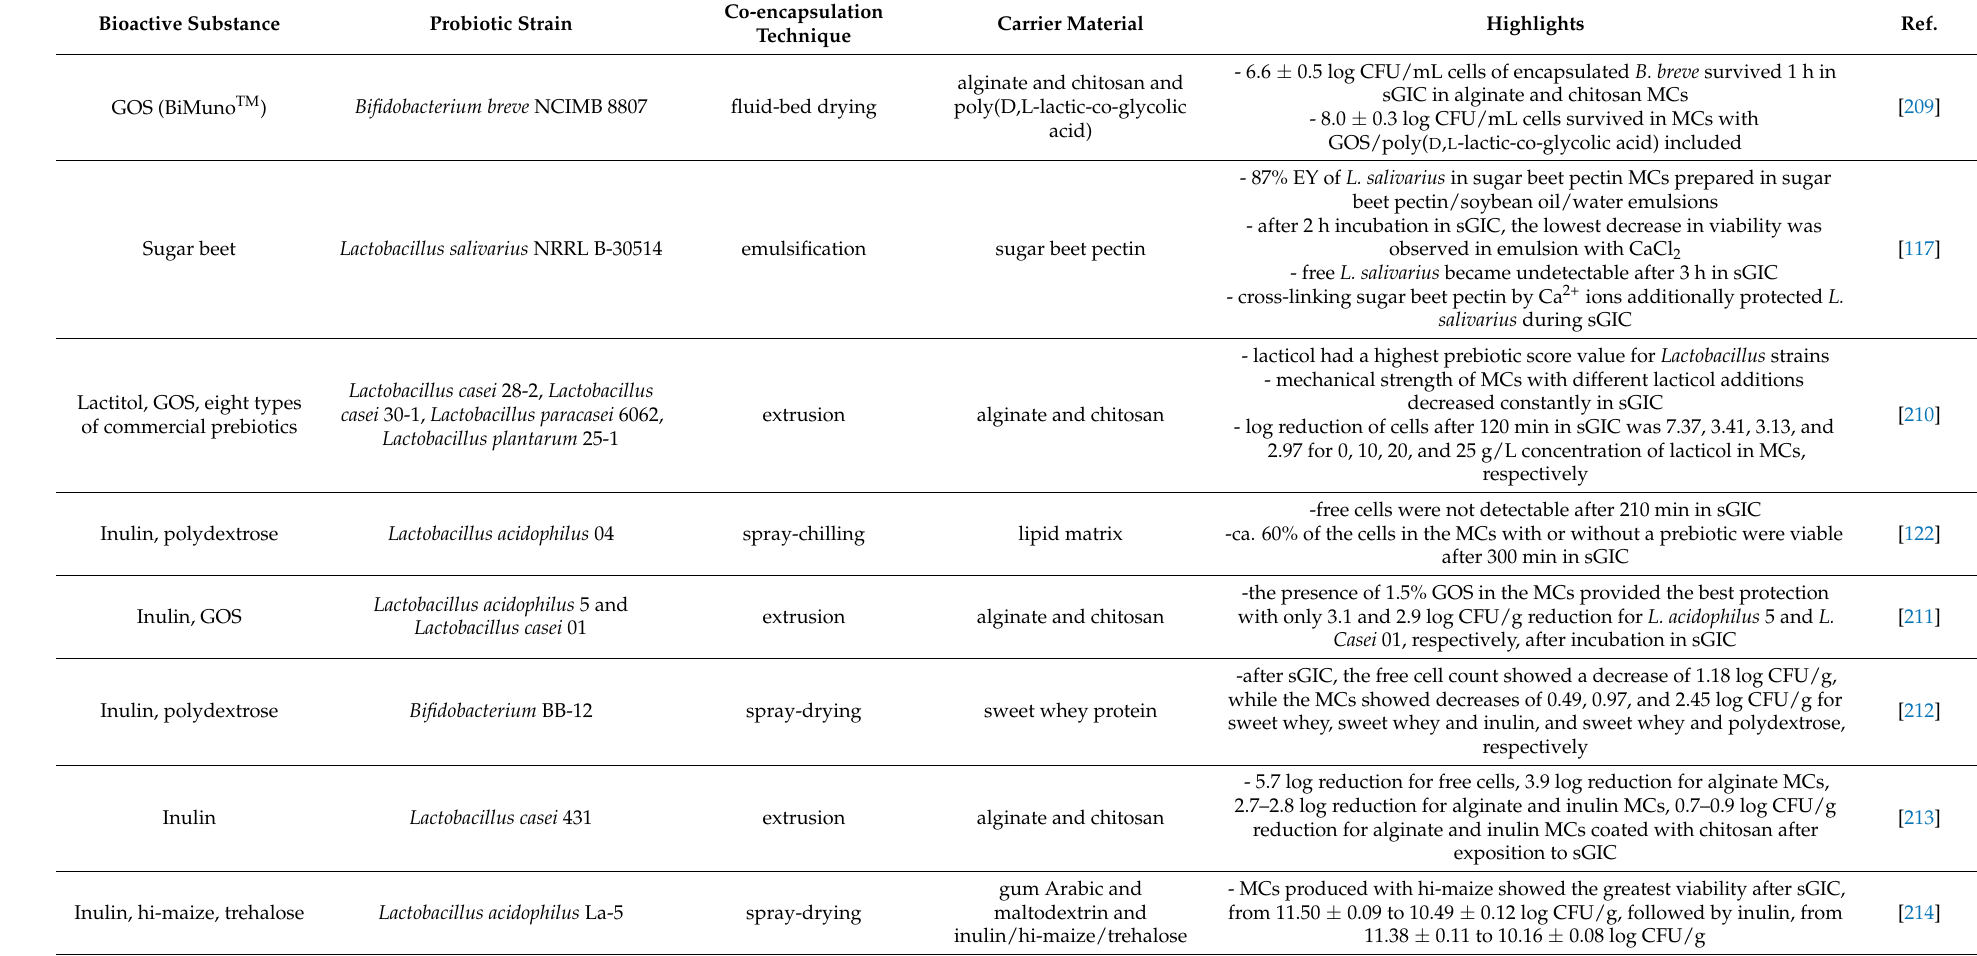
Table 2. Probiotics co-encapsulated with dietary